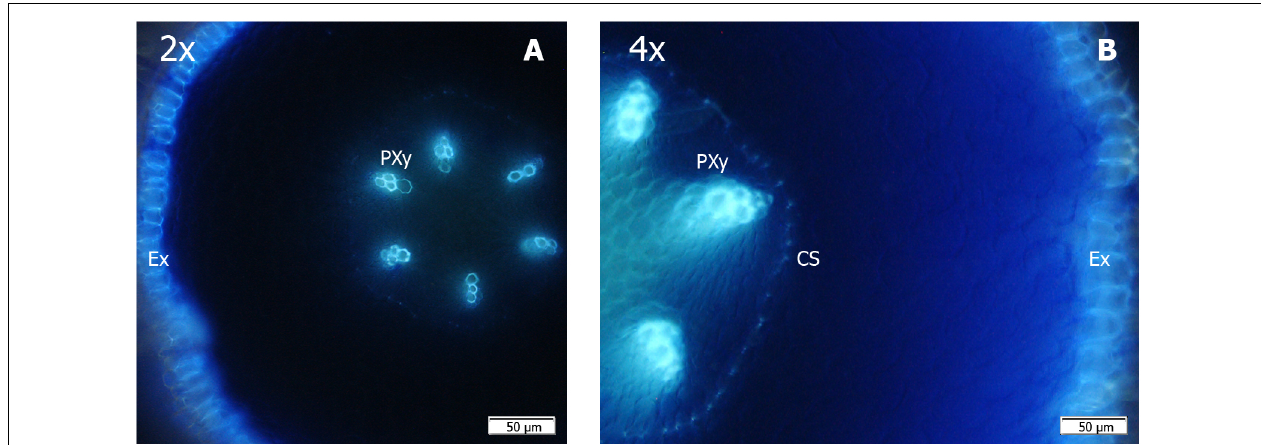
FIGURE 4 | Free-hand cross-sections of the roots of (A) the 2x and (B) 4x CC seedlings grown in vitro , taken at 9–12 mm from the root apex, cleared in chloral hydrate, stained with berberine hemisulfate, post-stained with aniline blue and visualized under the UV light of a fluorescence microscope. Casparian strip is clearly differentiated in the 4x root, while is slightly visible in the 2x root. PXy, Protoxylem; CS, Casparian strip; Ex, Exodermis.